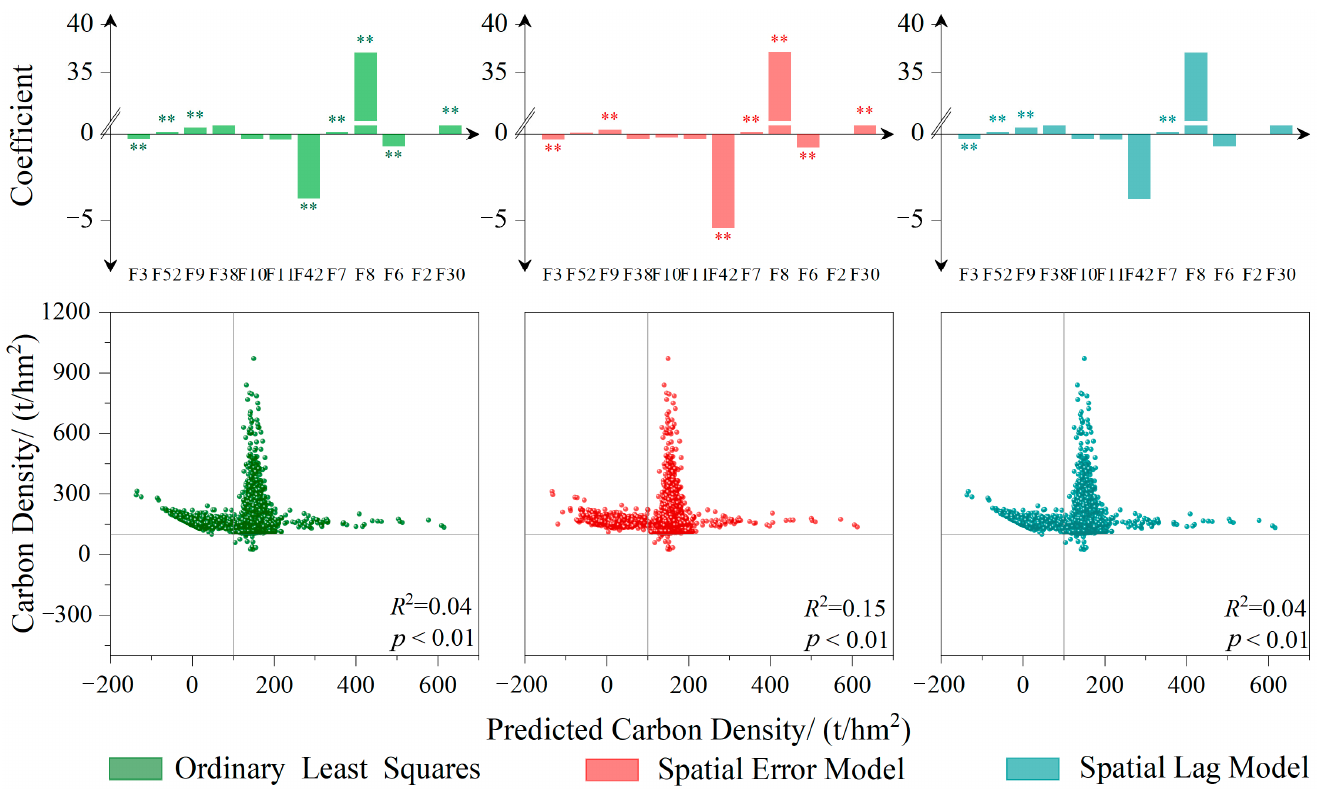
Figure 5. The parameter estimation results of the least square model, spatial error model, and spatial lag model. ** indicates significant differences at p < 0.01 (Significant test).